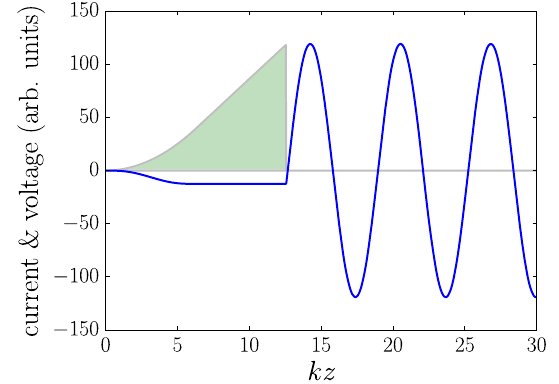
FIG. 2. Example of “ quadratic ” current profiles given by Eq. (13) (shaded line) with corresponding induced voltage. The parameters are ν ¼ 1 and N ¼ 5 . The head of the bunch is at kz ¼ 0 .